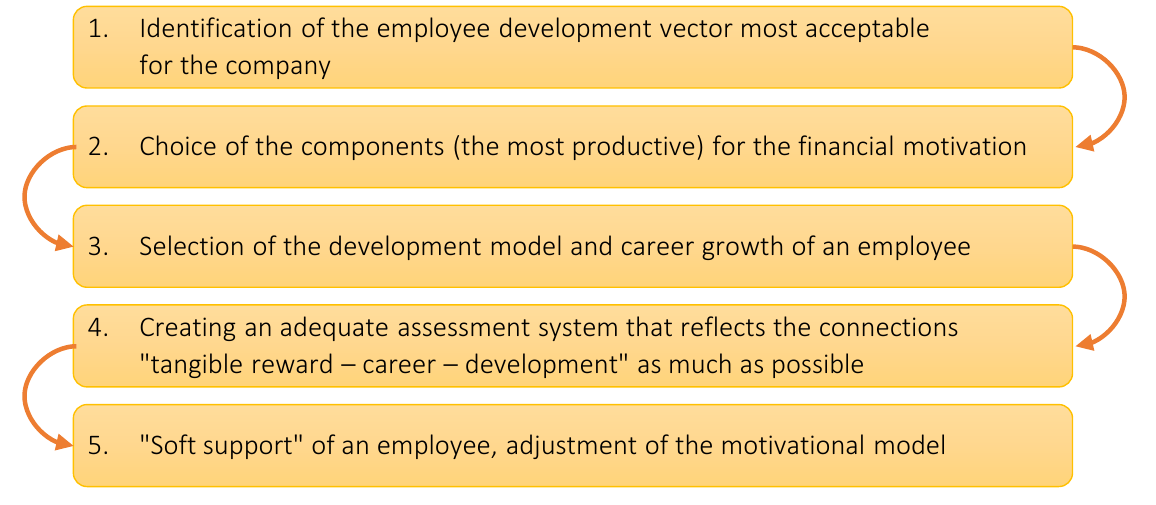
Figure 5. Implementation of an algorithm for a career-oriented strategy for motivating young